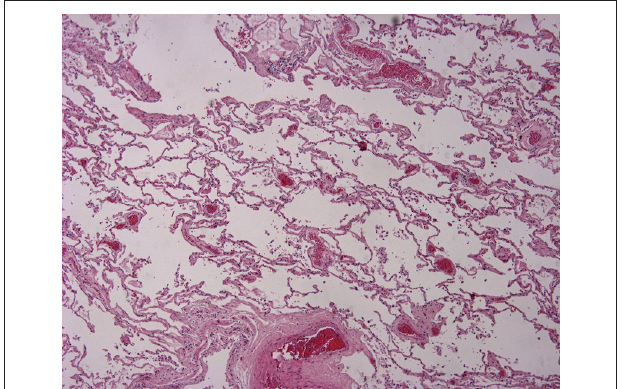
FIGURE 3 | Histological examination after hematoxylin and eosin staining technique. Normal lung samples. Imagine courtesy of Prof. Monica Salerno, Department of Medical, Surgical and Advanced Technologies G.F. Ingrassia, University of